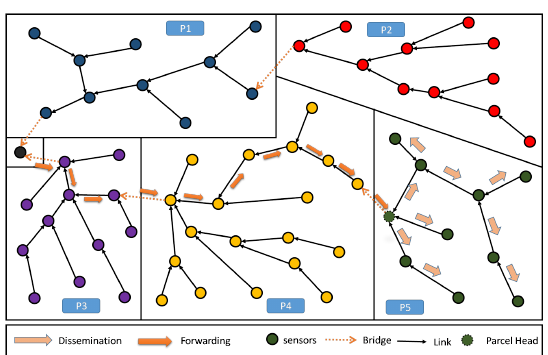
Figure 16. Spatial queries dissemination with RPL.